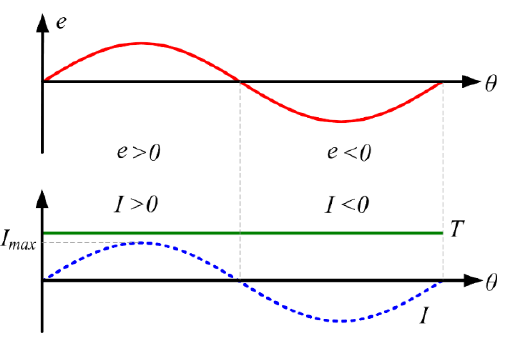
Figure 3. Theoretical operating waveforms of brushless ac (BLAC) operation (red: back-electromotive force (EMF); green: torque; blue: armature current.)